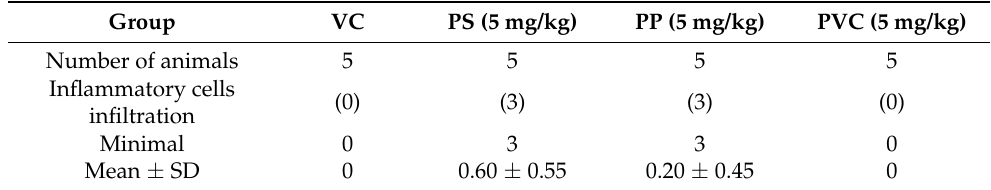
0, no symptoms; 1, minimal. Data are presented as the mean ± SD.